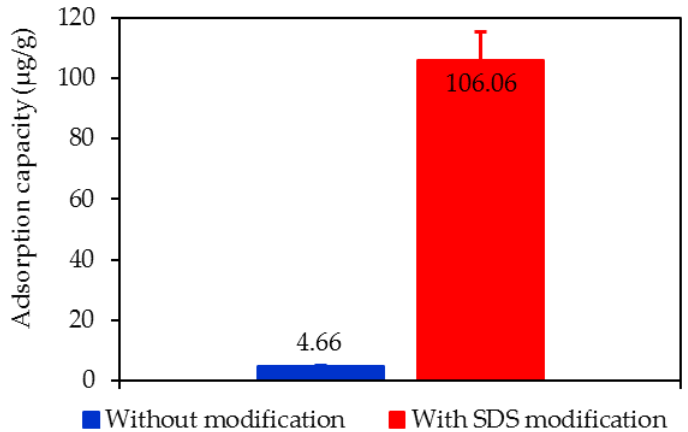
Figure 8. Adsorption capacity of lindane using synthesized nano-aluminum hydroxide (NAH) without and with SDS modification ( C i (lindane) = 1500 µ g / L, pH 6, contact time 60 min, adsorbent dosage 25 mg / mL). Error bars indicate the standard deviations of three replicates.